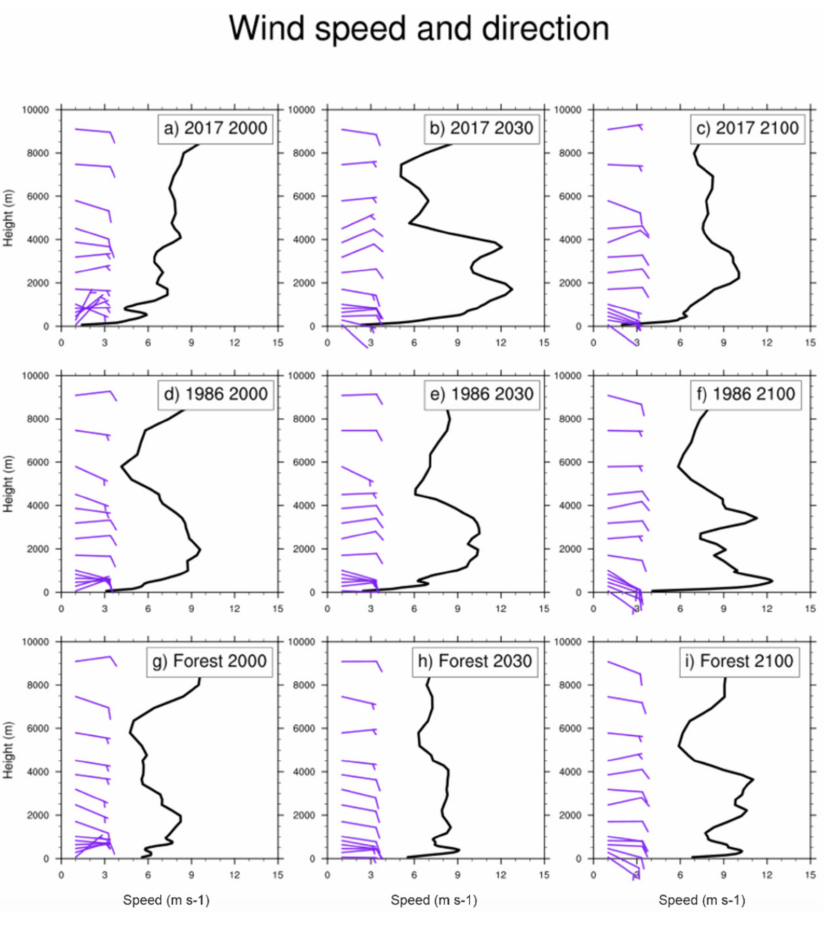
Figure 15. Wind speed (solid line) and wind direction (barbs) vertical profiles for each scenario at 2000, 2030, and 2100 UTC.